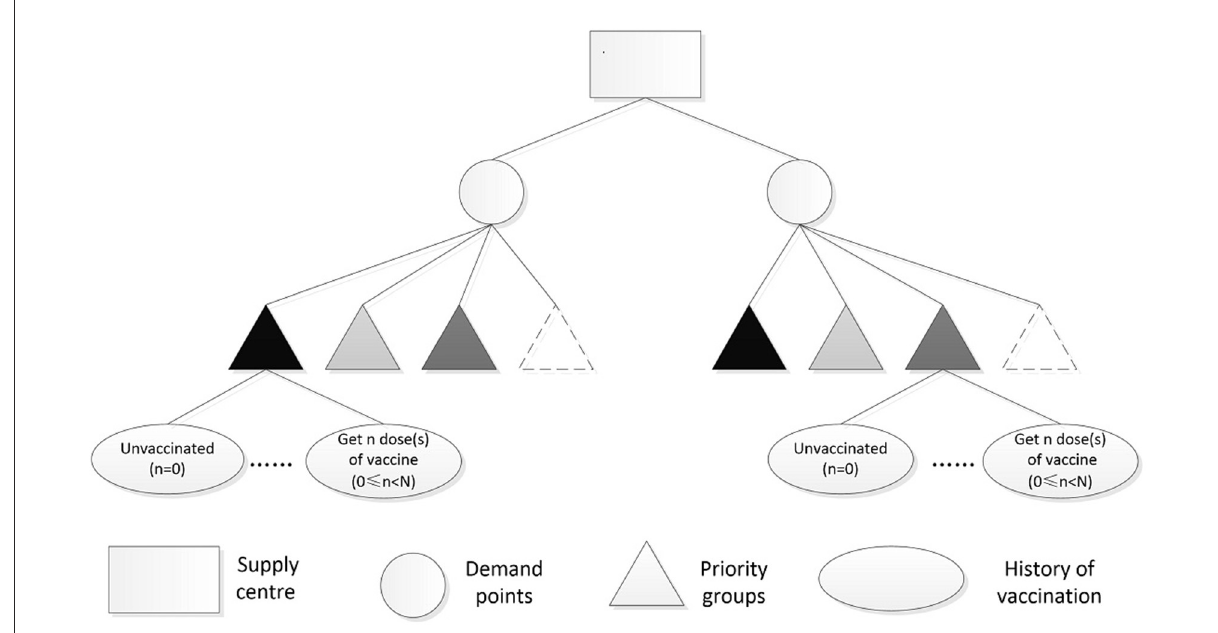
FIGURE1 Distribution of COVID-19